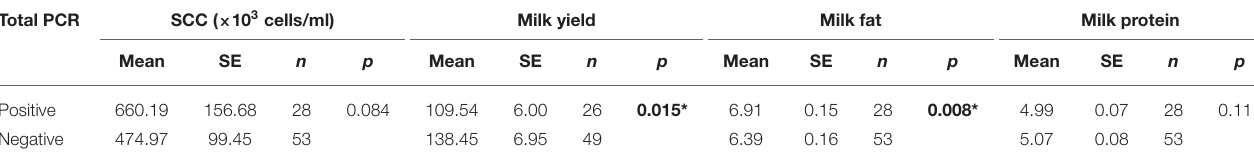
TABLE 7 | Milk production parameters evaluated in ELISA-positive animals from Flocks C and D from the Latxa breed according to PCR infection status. Total